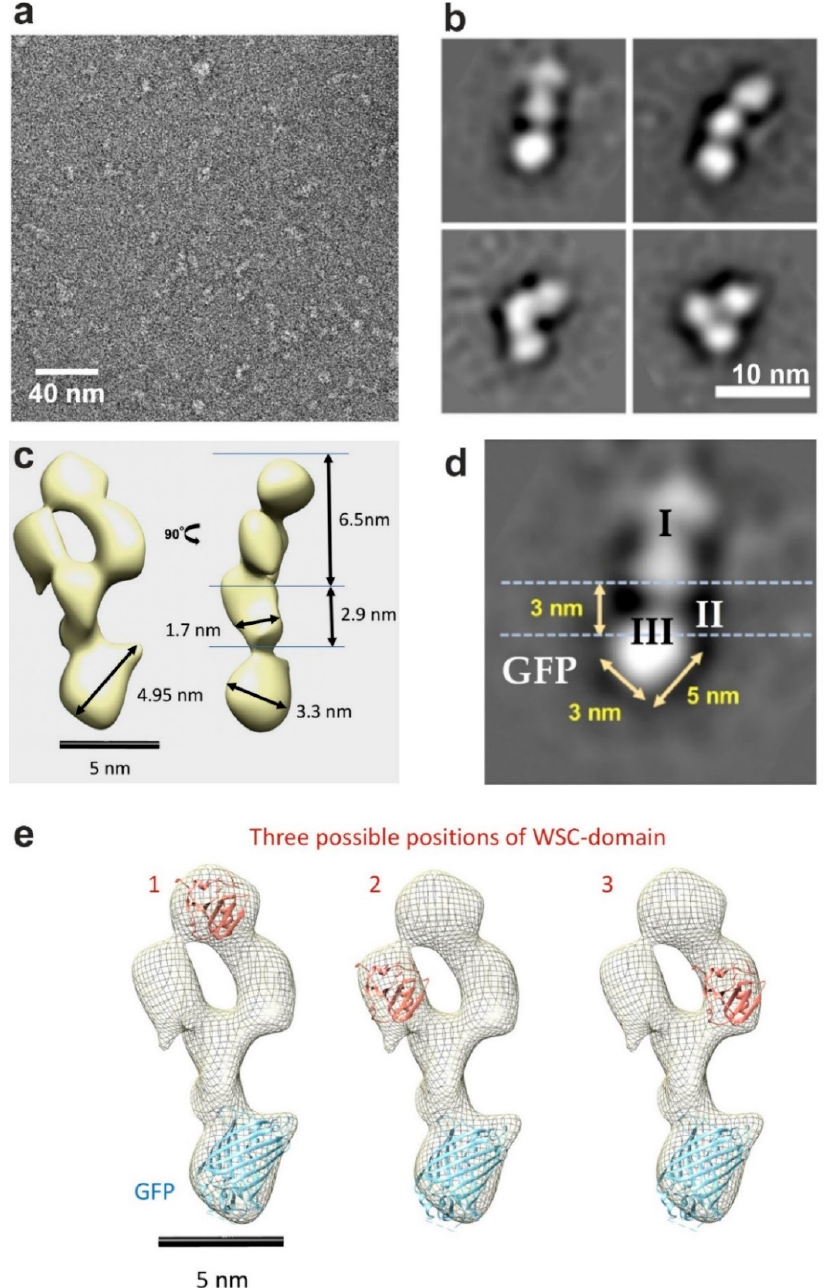
Figure 4. Construction of a three-dimensional model of the tagged Wsc1 sensor. ( a ) Images of the purified Wsc1-carrying SMALP preparation obtained by negative-stain transmission electron microscopy. ( b ) Four representative examples of two-dimensional class images of the Wsc1-GFP sensor fusion. 2D classes that are representative of those used for the 3D reconstruction are shown in the two images of the upper row. ( c ) Three-dimensional reconstruction of the sensor structure. Measurements were performed in ImageJ [53]. The two views depicted in were obtained by successive 90 ◦ rotations around the vertical axis. ( d ) 2D class-average of the extended Wsc1-GFP construct with designated domains, depicting their dimensions and the proposed position of the membrane. I, II, and III designate the proposed extracellular, transmembrane, and cytosolic domains, respectively. ( e ) Possible locations of homologous domains with a resolved crystal structure. The structure of GFP (pdb ID 4OGS) was fitted into the presumed cytosolic extension of the protein (blue ribbon) and the crystal structure homologous to the WSC domain of KRM1 (pdb ID 5FWS) would fit into any of the three cytosolic densities shown (salmon